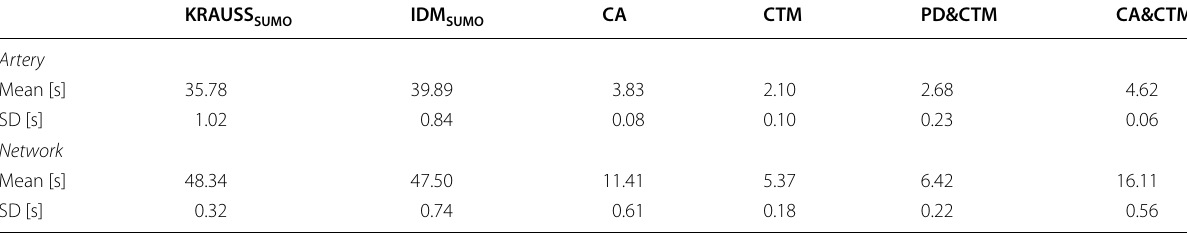
Table 6 Models’ comparison in terms of elapsed